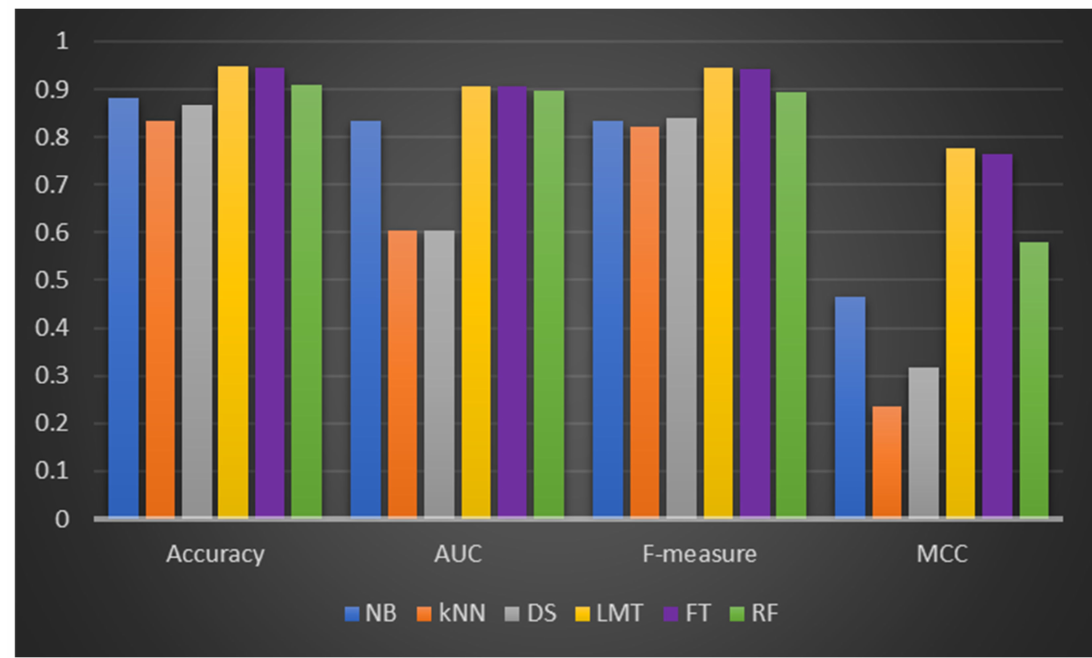
Figure 2. CCP Performance of DF models and ML Classifiers on Dataset 1.